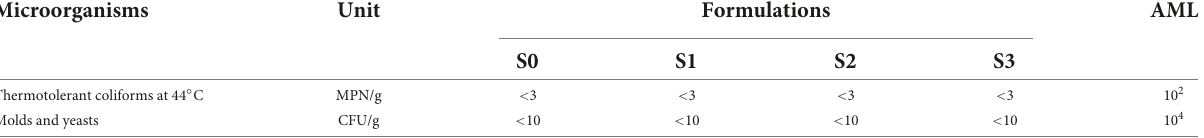
TABLE 4 Microbiological quality of sequilhos-type biscuits under different concentrations of macaúba almond flour. Microorganisms